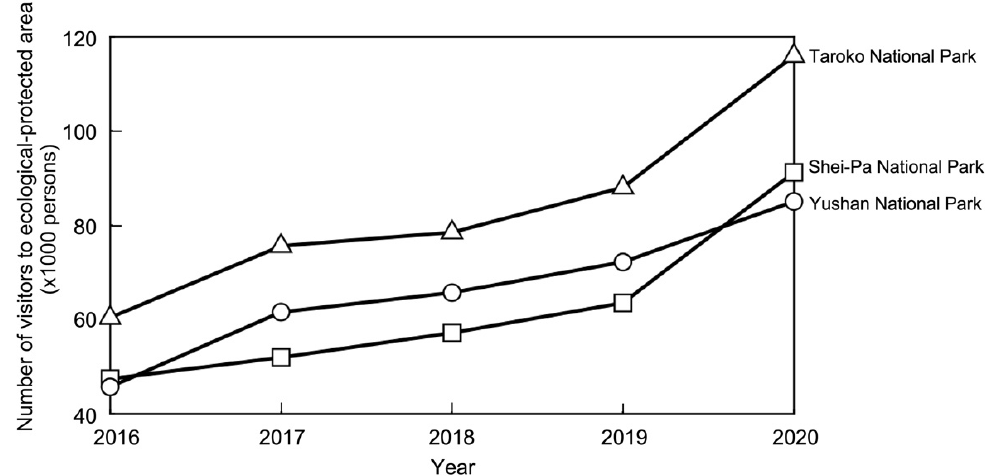
Figure 6. The annual number of visitors to the ecological-protected areas of Yushan, Shei-Pa, and Taroko National Parks from 2016 to 2020 (The graph presents a compilation of data provided by the national park headquarters).